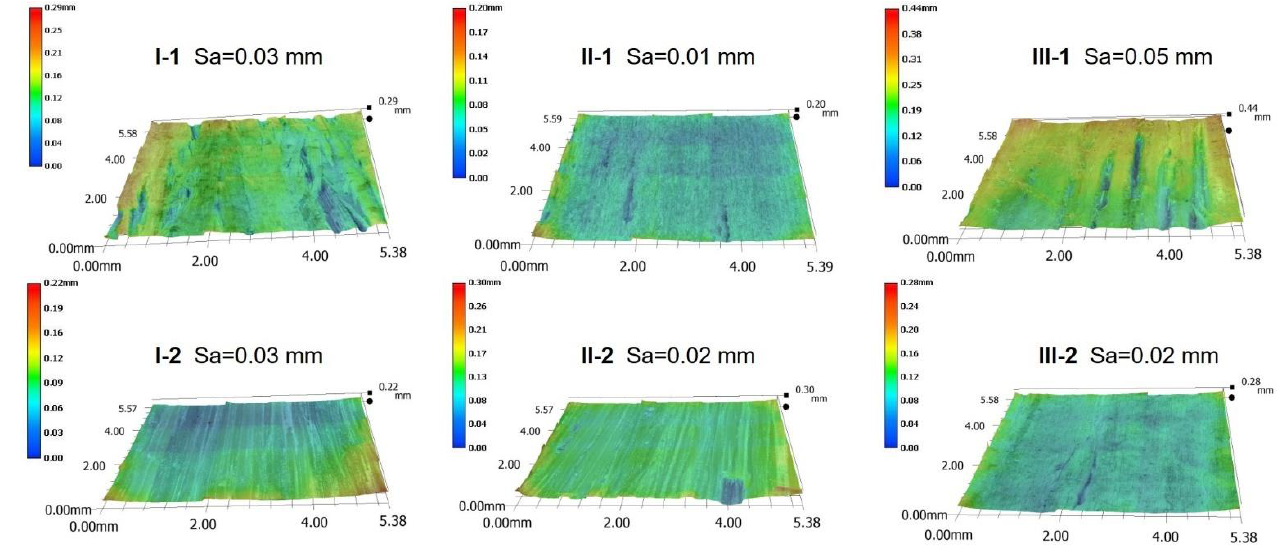
Figure 4. 3D surface images of the LC samples. Sa = arithmetic average height (area).